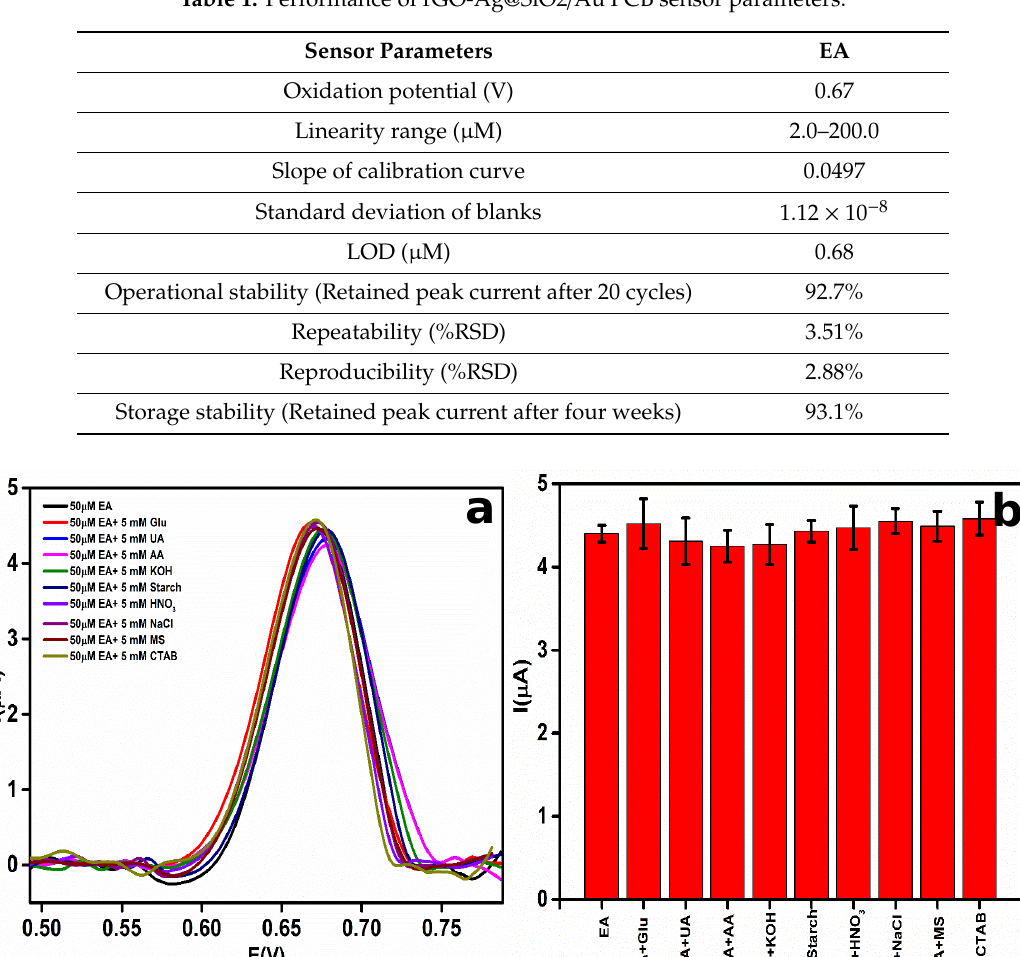
Table 1. Performance of rGO-Ag@SiO2 / Au PCB sensor parameters.